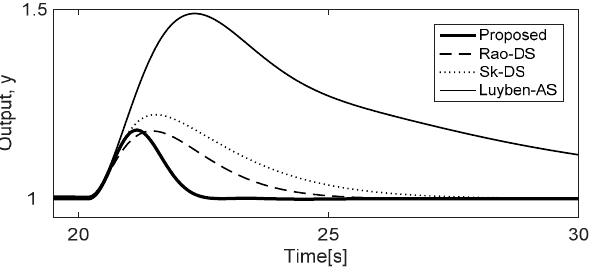
Figure 9. Regulatory responses to disturbance in PIPTD under Gaussian noise N(0, 0.05 2 ). Table 6. Quantitative comparison of the responses to disturbance in PIPTD under Gaussian noise N(0, 0.05 2 ).